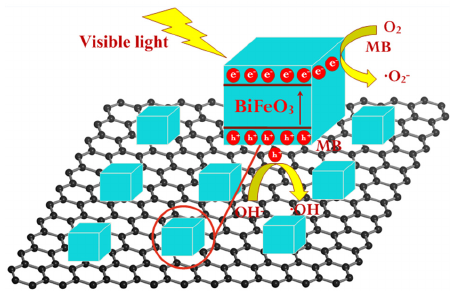
Figure 5. The photocatalytic mechanism diagram of 3D BFO/graphene composites.